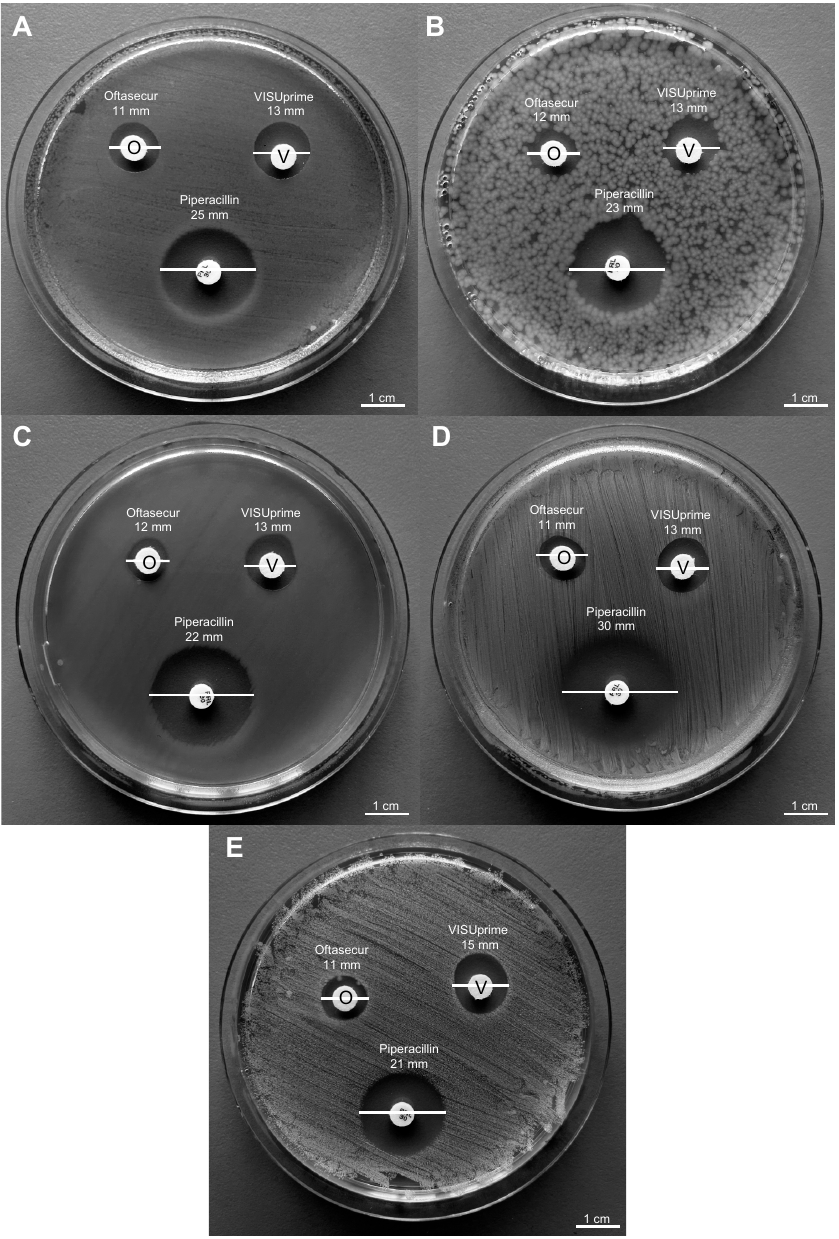
Figure 2. Oftasecur (O) and Visuprime (V) inhibition zone against E. coli ( A ), K. pneumoniae ( B ), P. aeruginosa ( C ), S. aureus ( D ), and S. epidermidis ( E ). Piperacillin (30 µ g) was used as CTRL+.